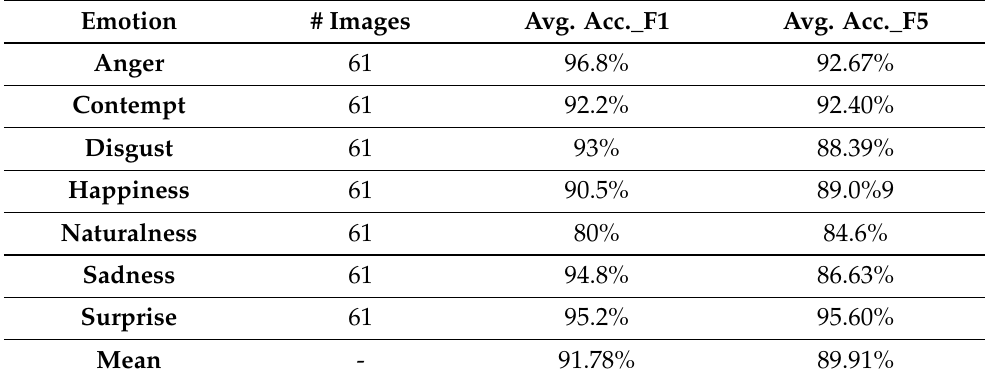
Table 5. Performance per class and average accuracy using both models, achieved with one-fold and five-fold cross-validation, on test set from SASE-FE dataset.